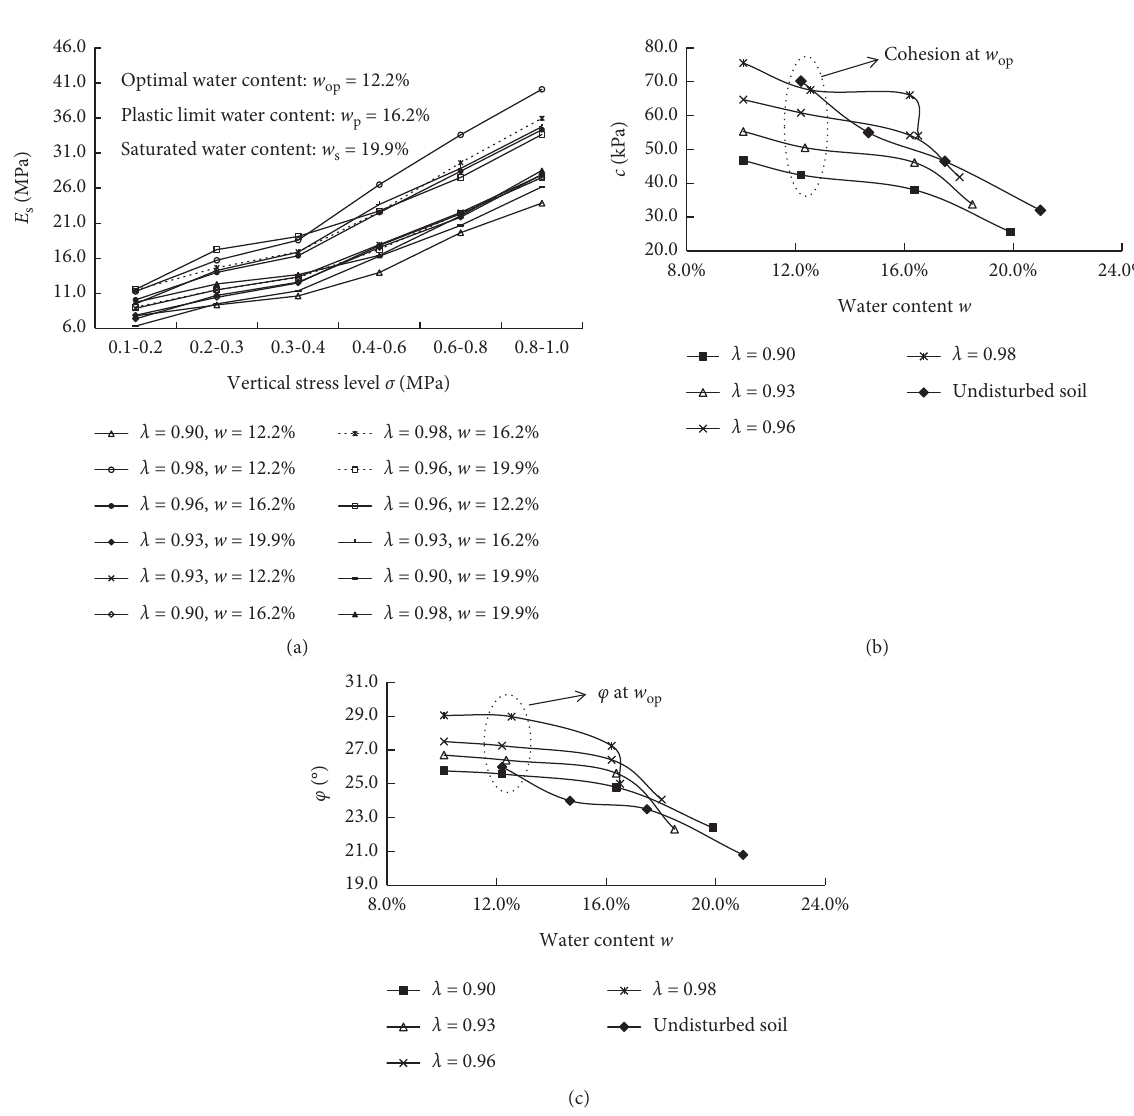
Figure 7: Mechanical parameters of compacted Q 2 loess. (a) Compression modulus at various compaction degrees and water contents. (b) Cohesion at various compaction degrees and water contents. (c) Internal friction angle at various compaction degrees and